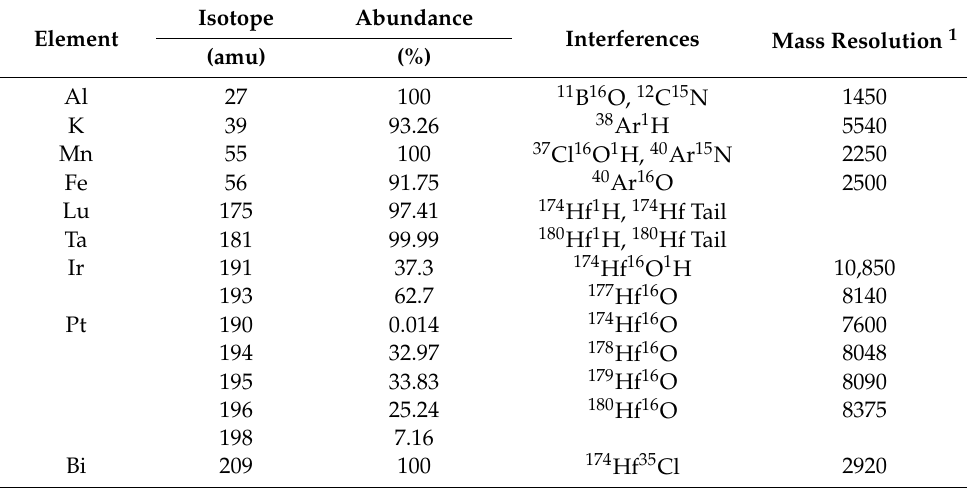
Table 2. Drawbacks affecting the ICP-MS